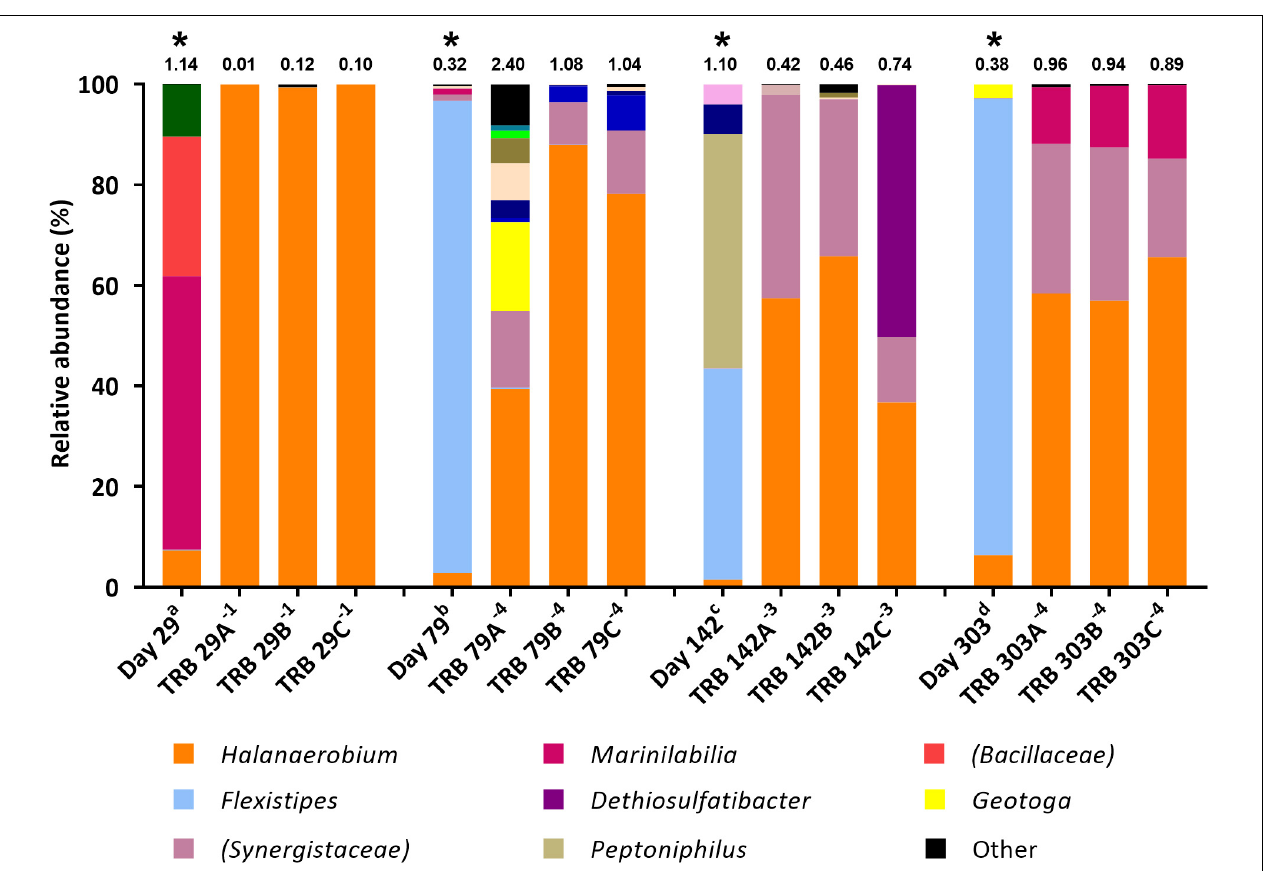
FIGURE 4 | Genus-level microbial community composition of TRB MPN enrichments amended with yeast extract, based on 16S rRNA gene sequencing. Enrichments were conducted at 10% salinity. Where identity at genus level could not be resolved the highest resolved taxonomic level is given in brackets. The Shannon diversity index calculated from operational taxonomic units is displayed above each bar. a 808 days storage, b 758 days storage, c 695 days in storage, and d 534 days storage, * indicates inocula. Key taxa are highlighted in legend. Enrichments were conducted in triplicate where A, B, C refers to specific replica and superscript power refers to dilution factor of the positive end-points